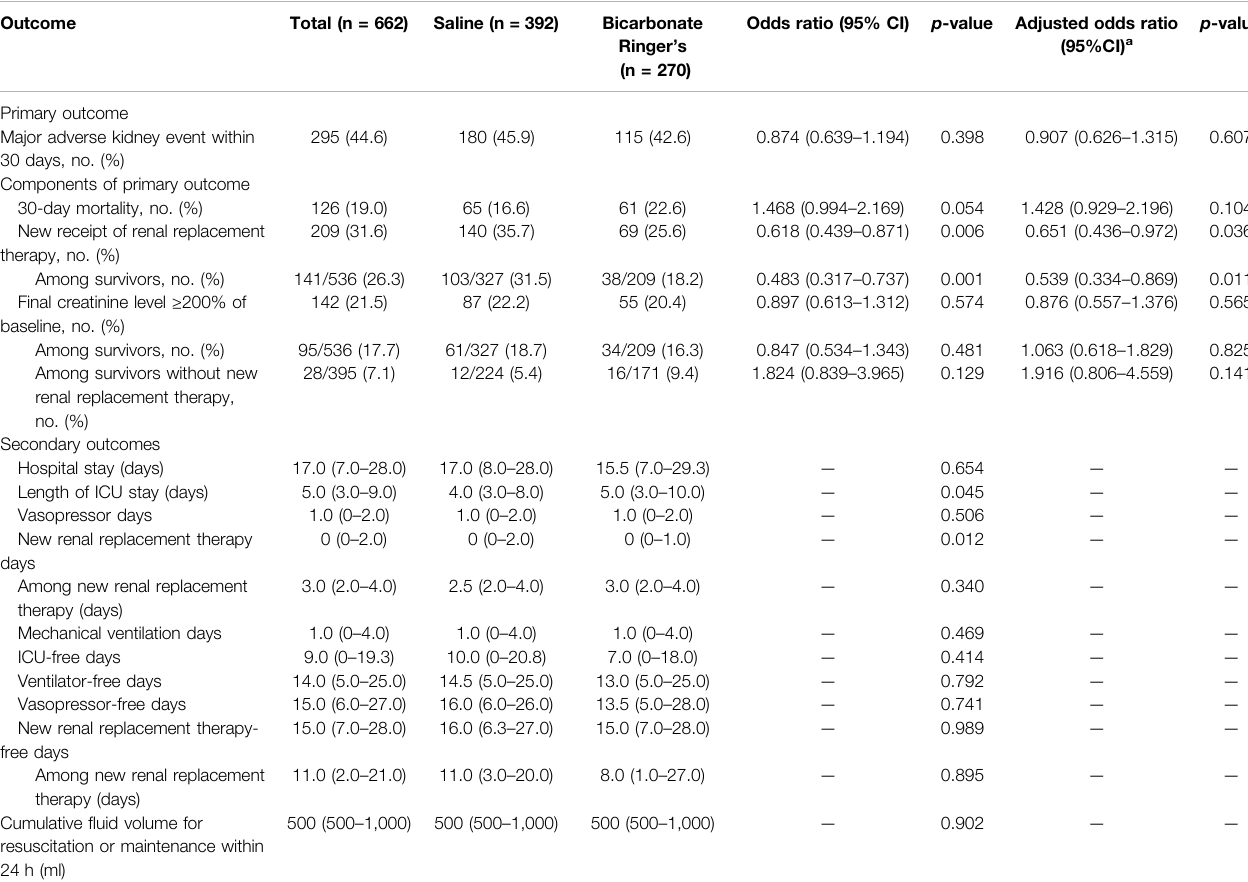
TABLE 2 | Primary and secondary outcomes.